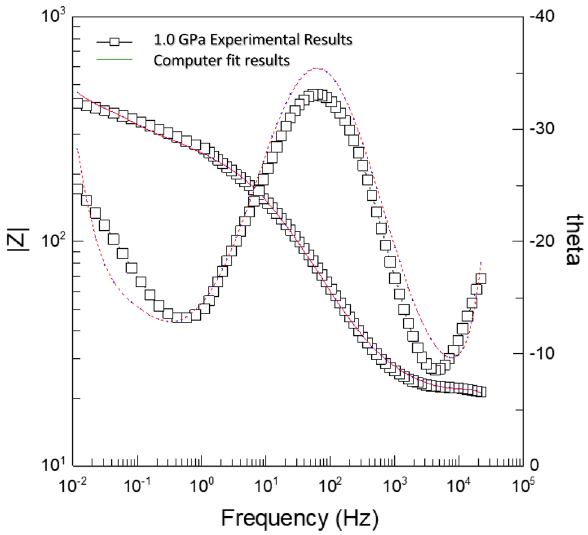
Figure 5. The experimental and fit result of Bode and theta plots for (Bi, Pb)-2223 superconductor electrode compacted at 1.4 GPa in 0.5 M HCl.